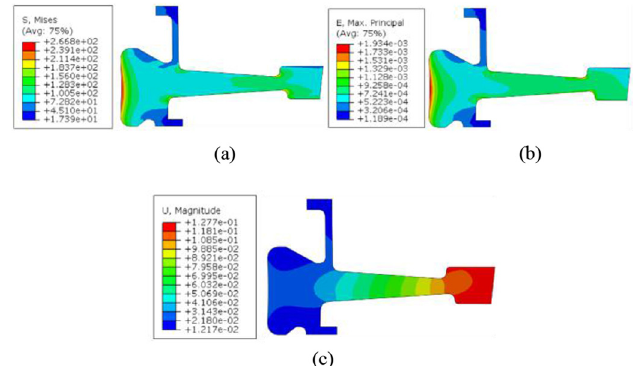
Fig. 6. Simulation results of FGM turbine disk in idle state: (a) von Mises stress distribution nephogram, (b) strain distribu- tion nephogram, and (c) deformation distribution nephogram.